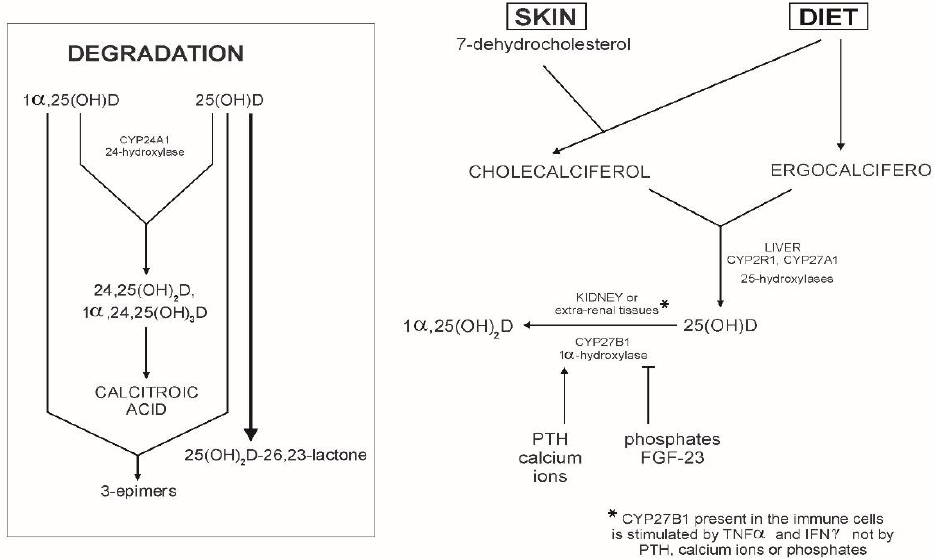
Figure 1. Metabolic pathways of vitamin D. Abbreviations: CYP24A1 (cytochrome P450-associated 24-hydroxylase); CYP2R1 and CYP27A1 (cytochrome P450-associated 25-hydroxylases);